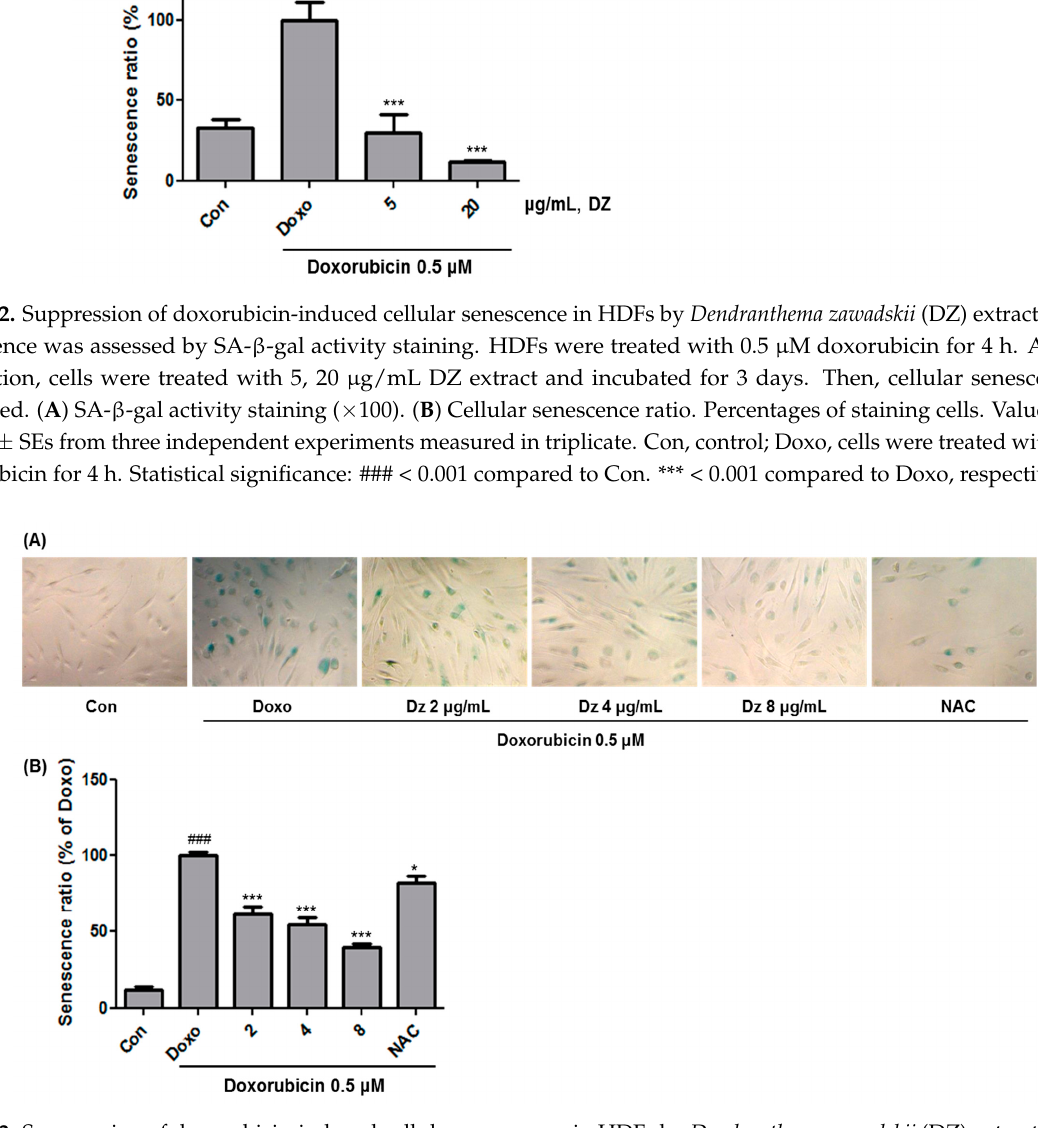
Figure 3. Suppression of doxorubicin-induced cellular senescence in HDFs by Dendranthema zawadskii (DZ) extract. Cellular senescence was assessed by SA- β -gal activity staining. HDFs were treated with 0.5 μ M doxorubicin for 4 h. After 24 h incubation, cells were treated with 2, 4, 8 μ g/mL DZ extract and incubated for 3 days. Then, cellular senescence was measured. Con, control; Doxo, cells were treated with 0.5 μ M doxorubicin for 4 h; NAC, 5 mM N-acetyl-L-cysteine. ( A ) SA- β - gal activity staining (×100). ( B ) Cellular senescence ratio. Percentages of staining cells. Values are the means ± SEs from three independent experiments measured in triplicate. Statistical significance: ### < 0.001 compared to Con. *** < 0.001 compared to Doxo, * < 0.05 compared to Doxo, respectively.